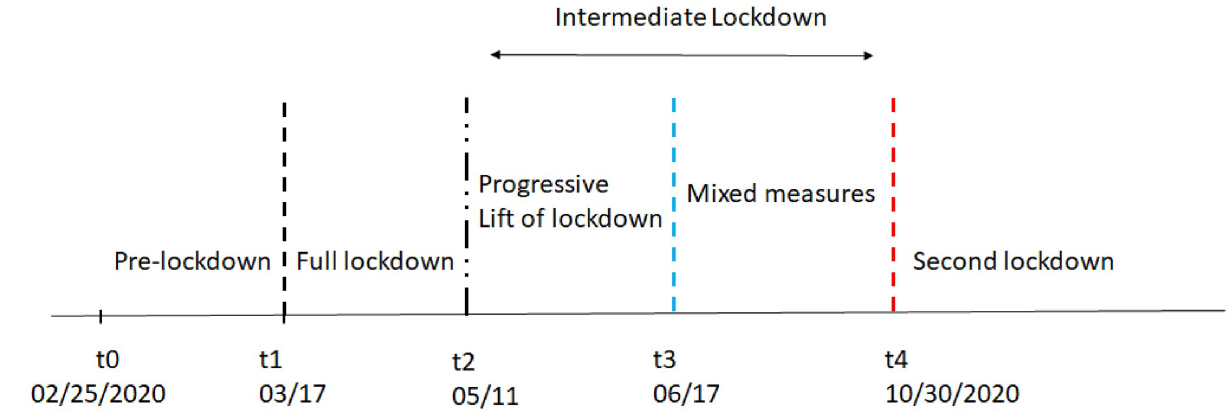
Fig 1. Periods and time